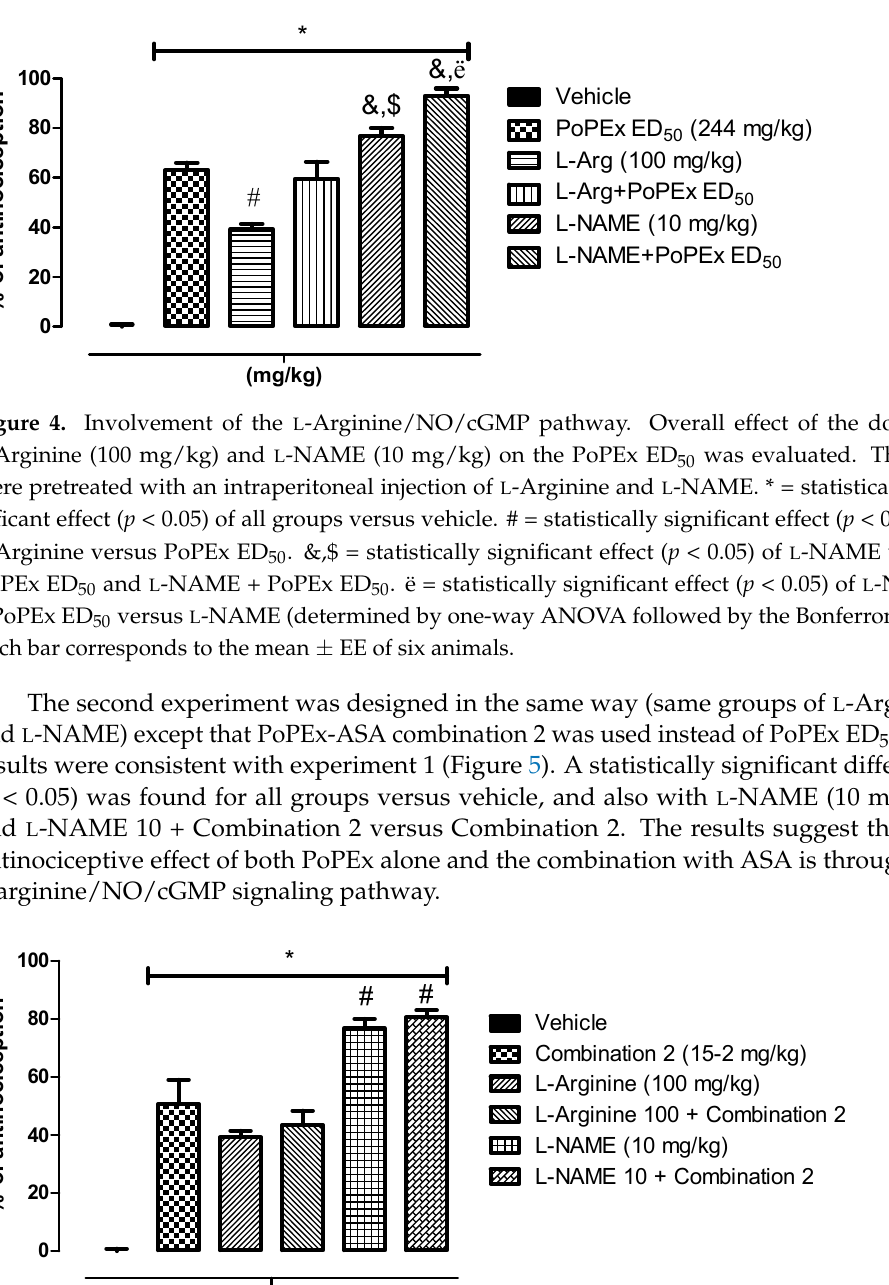
Figure 5. Involvement of the L -Arginine/NO/cGMP pathway. Overall effect of the doses of L -argi- nine (100 mg/kg) and L -NAME (10 mg/kg) on combination 2 (15 mg PoPEx/2 mg ASA) was evalu- ated. The rats were pretreated with an intraperitoneal injection of L-arginine and L -NAME. * =